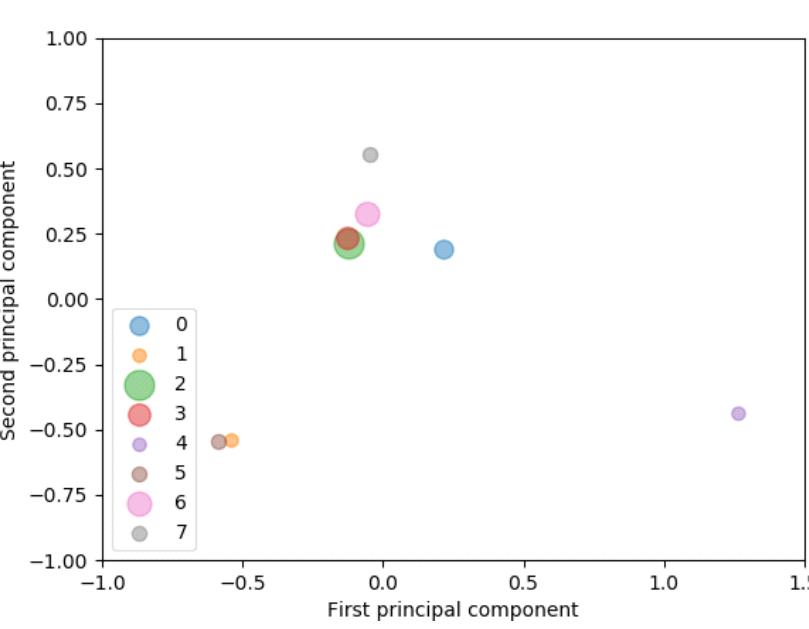
Figure 8. Lifetime of issue ticket categories.